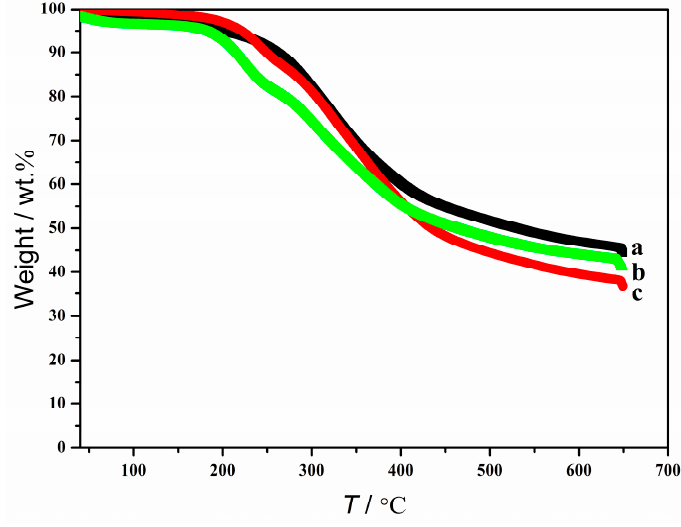
Figure 3. Thermal decomposition profiles of lignin: ( a ) the original lignin; ( b ) the regenerated lignin from [Ch][Fa] ( R = 10:1)/H 2 O/lignin solution; ( c ) the regenerated lignin from [Ch][Na] ( R = 8:1)/H 2 O/lignin solution.